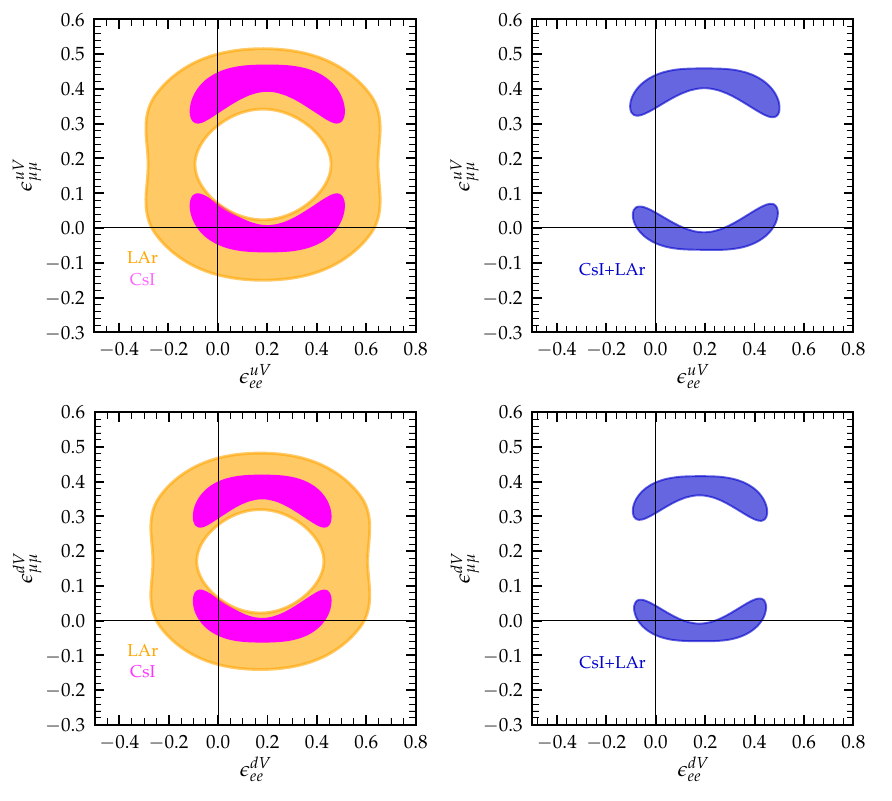
Figure 4 . Same as figure 3 but in the ( (cid:15) qV